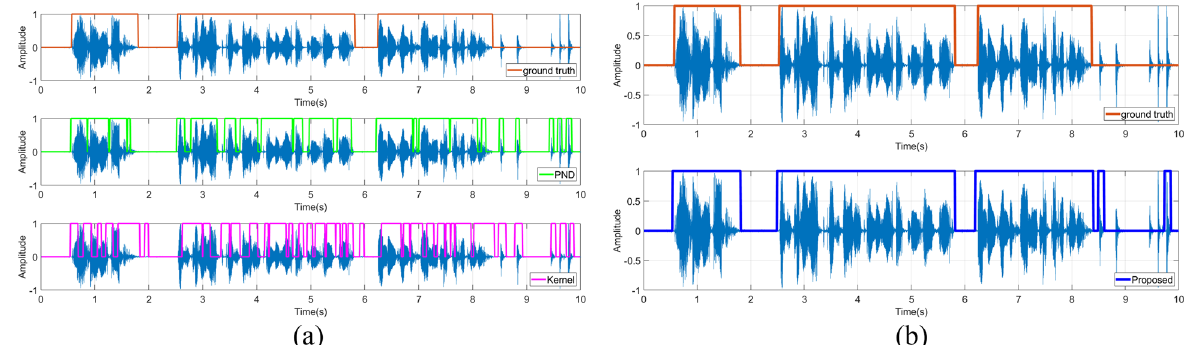
Fig. 8 The performance of the proposed detector, with a transient of keyboard tapping. The light blue line is the input audio signal with transient, and the red line is the ground‑truth representing the frames containing speech. The green, magenta and dark blue line are the detection result of “PND,” “Kernel,” and “Proposed,” respectively